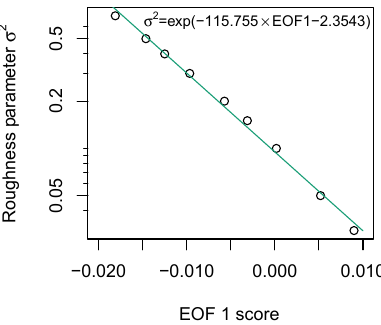
Figure 6. The pairs of EOF scores needed to reconstruct the original − P 12 . The EOF 1 score is a monotonic function of particle rough- ness parameter σ 2 . The EOF 2 score reaches a minimum at particle roughness parameter of σ 2 = 0 . 1.